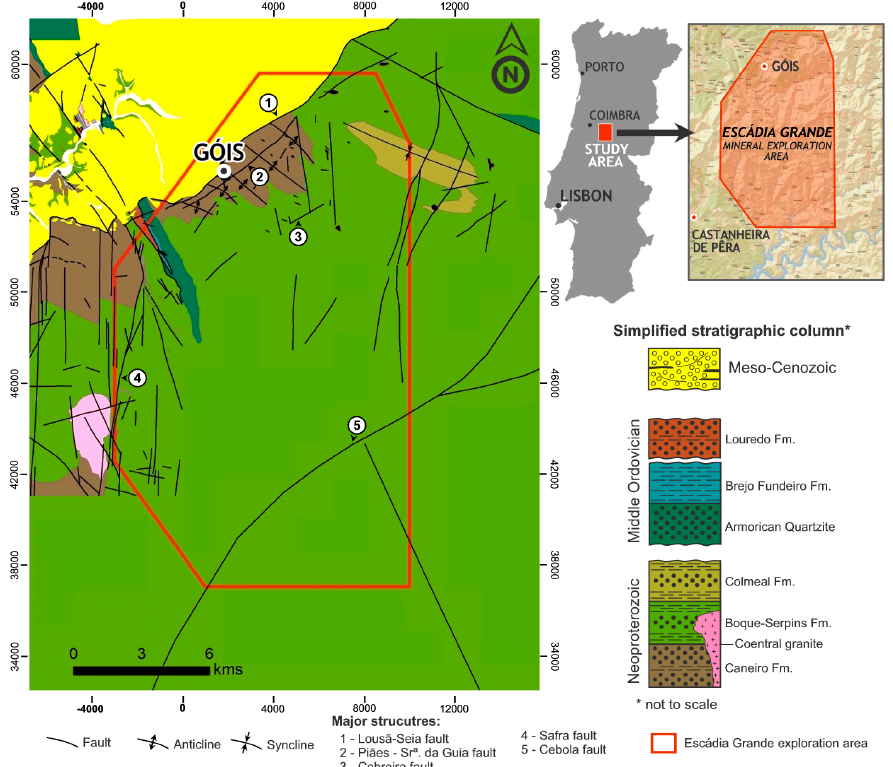
Figure 2. Location of the study area (including the mineral exploration area of Escádia Grande), simplified lithostratigraphic column and geological map (after [17–20]). The major tectonic structures of the region are numbered.